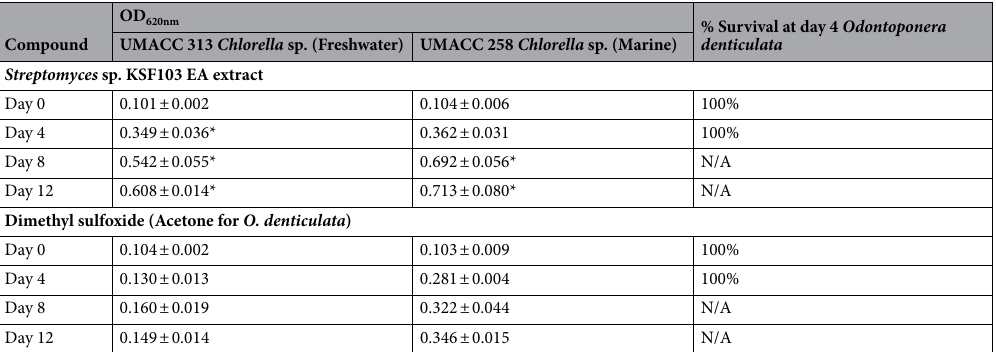
Table 4. Environmental toxicity of Streptomyces sp. KSF103 EA extract to the microalgae UMACC 313 Chlorella sp. and UMACC 258 Chlorella sp., and insect O. denticulata. Data expressed as mean ± standard deviation of the OD 620nm of both microalgal strains, and as percentage survival for O. denticulata. *Significant at P < 0.05 level versus negative control.